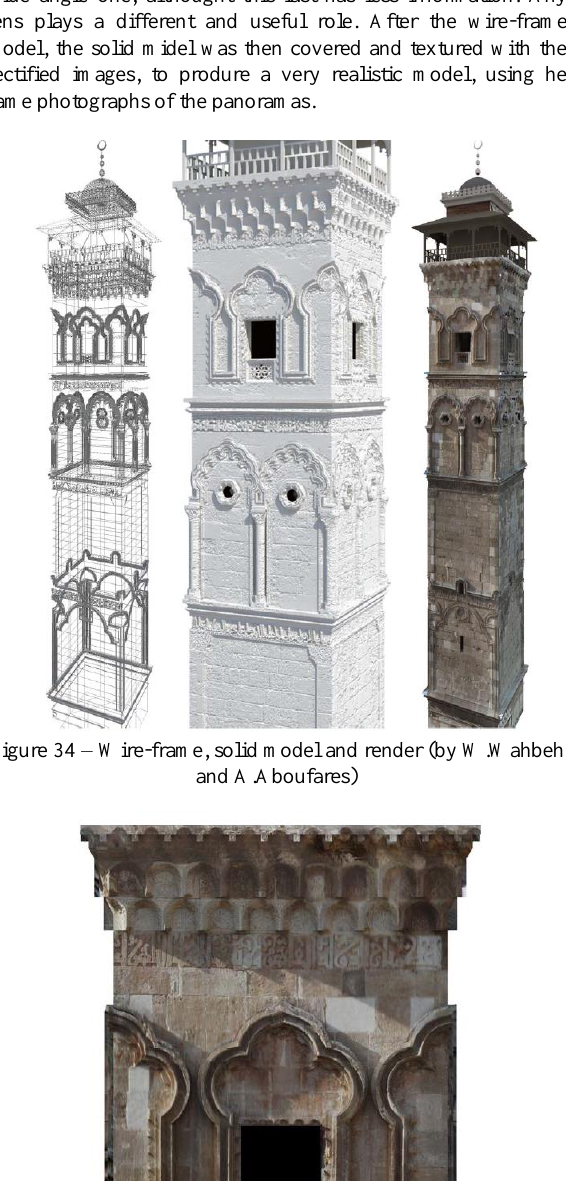
Figure 30 – The Citadel walls (plot by L.Piermattei) The photographs have been shot with a Canon 60D and 50mm